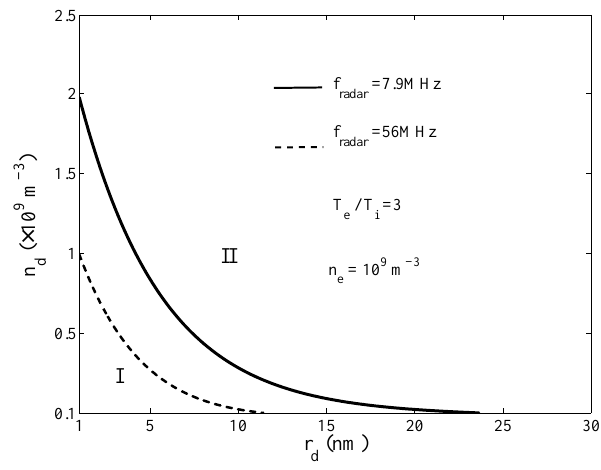
Fig. 7. The possibility of observing the turn-on overshoot. Region I shows the possible dust cloud parameter range for which turn-on overshoot is predicted to be observed. In Region II, the classic suppression of the PMSE strength after turn-on of the radio wave heating should be observed